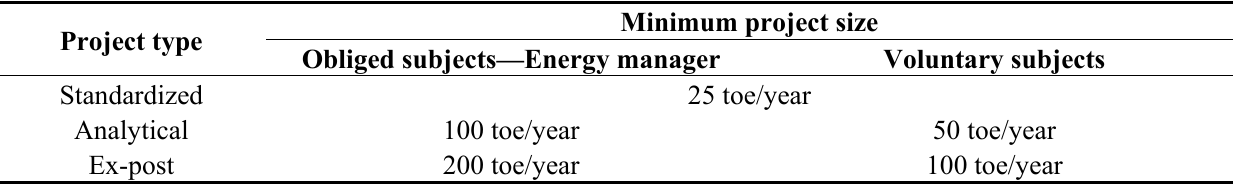
Table 6. Minimum threshold values. Source: Authority for Electricity and Gas